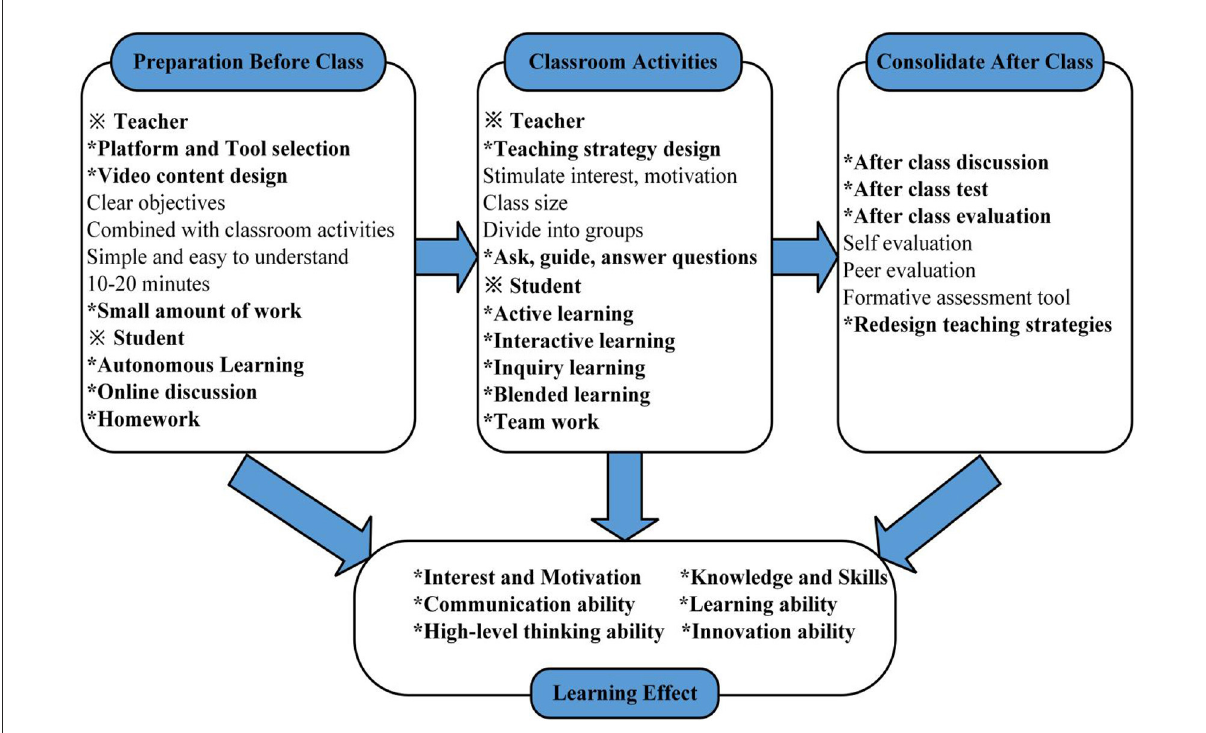
FIGURE7 Flipping classroom teaching mode